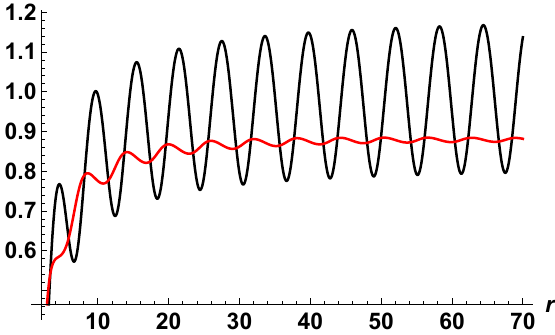
Figure 1. f ( r ) (black) and h ( r ) (red) obtained by solving the equations of motion of the quadratic theory as a function of the radial coordinate (in Planck